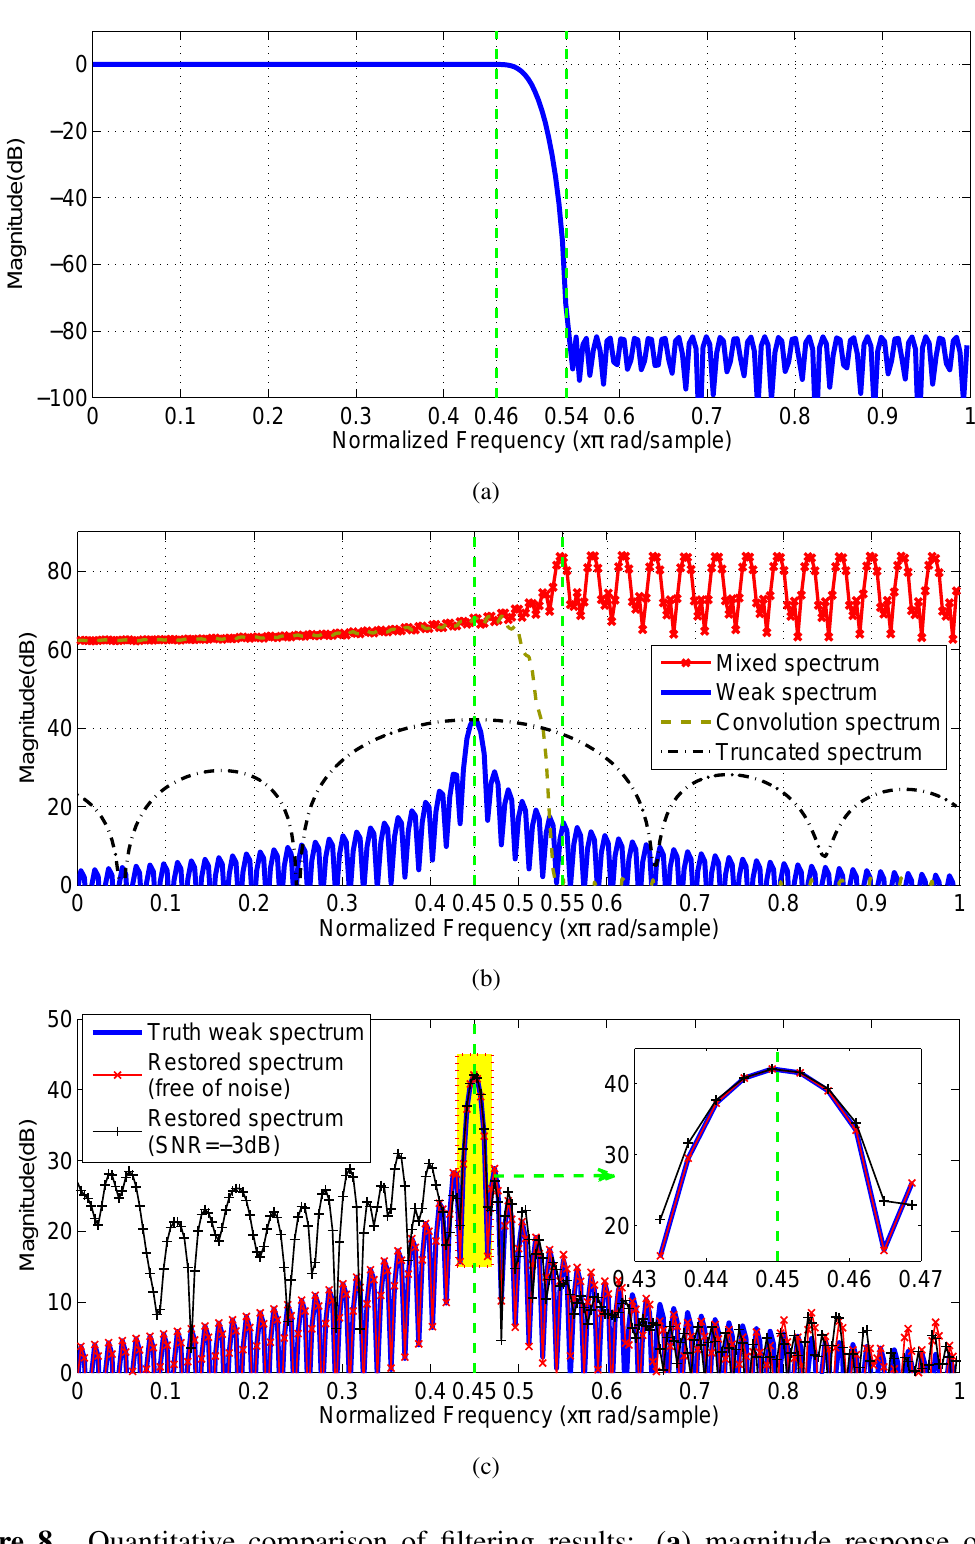
Quantitative comparison of filtering results: ( a ) magnitude response of the designed equiripple finite impulse response (FIR) half-band filter; ( b ) Fourier spectra of the mixed sequence, the truth weak component, the convolved sequence and the truncated sequence with 10 samples; ( c ) Fourier spectra of the truth weak component; the restored results by the proposed filtering strategy when the mixed sequence is free of noise or contaminated by noise (SNR = ´ 3